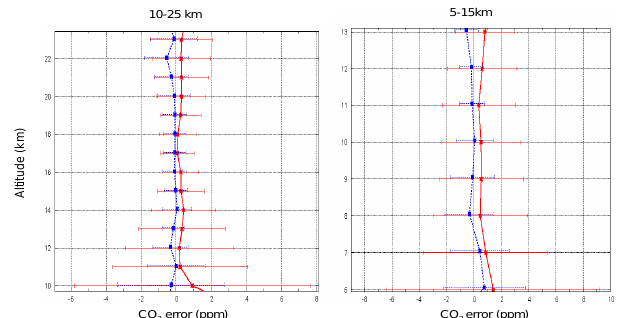
Fig. 4a. Results of synthetic retrievals of the CO 2 mixing ratio dif- ference (inppm) between the true profile and the retrieved profile (average over 20 occultations). Blue curve: all the uncertainties are considered as Gaussian random noise added to the “observations”; red curve: realistic temperature and species (N 2 O, O 3 , etc.) uncer- tainties are introduced in the atmospheric model; horizontal bars are one standard deviation.